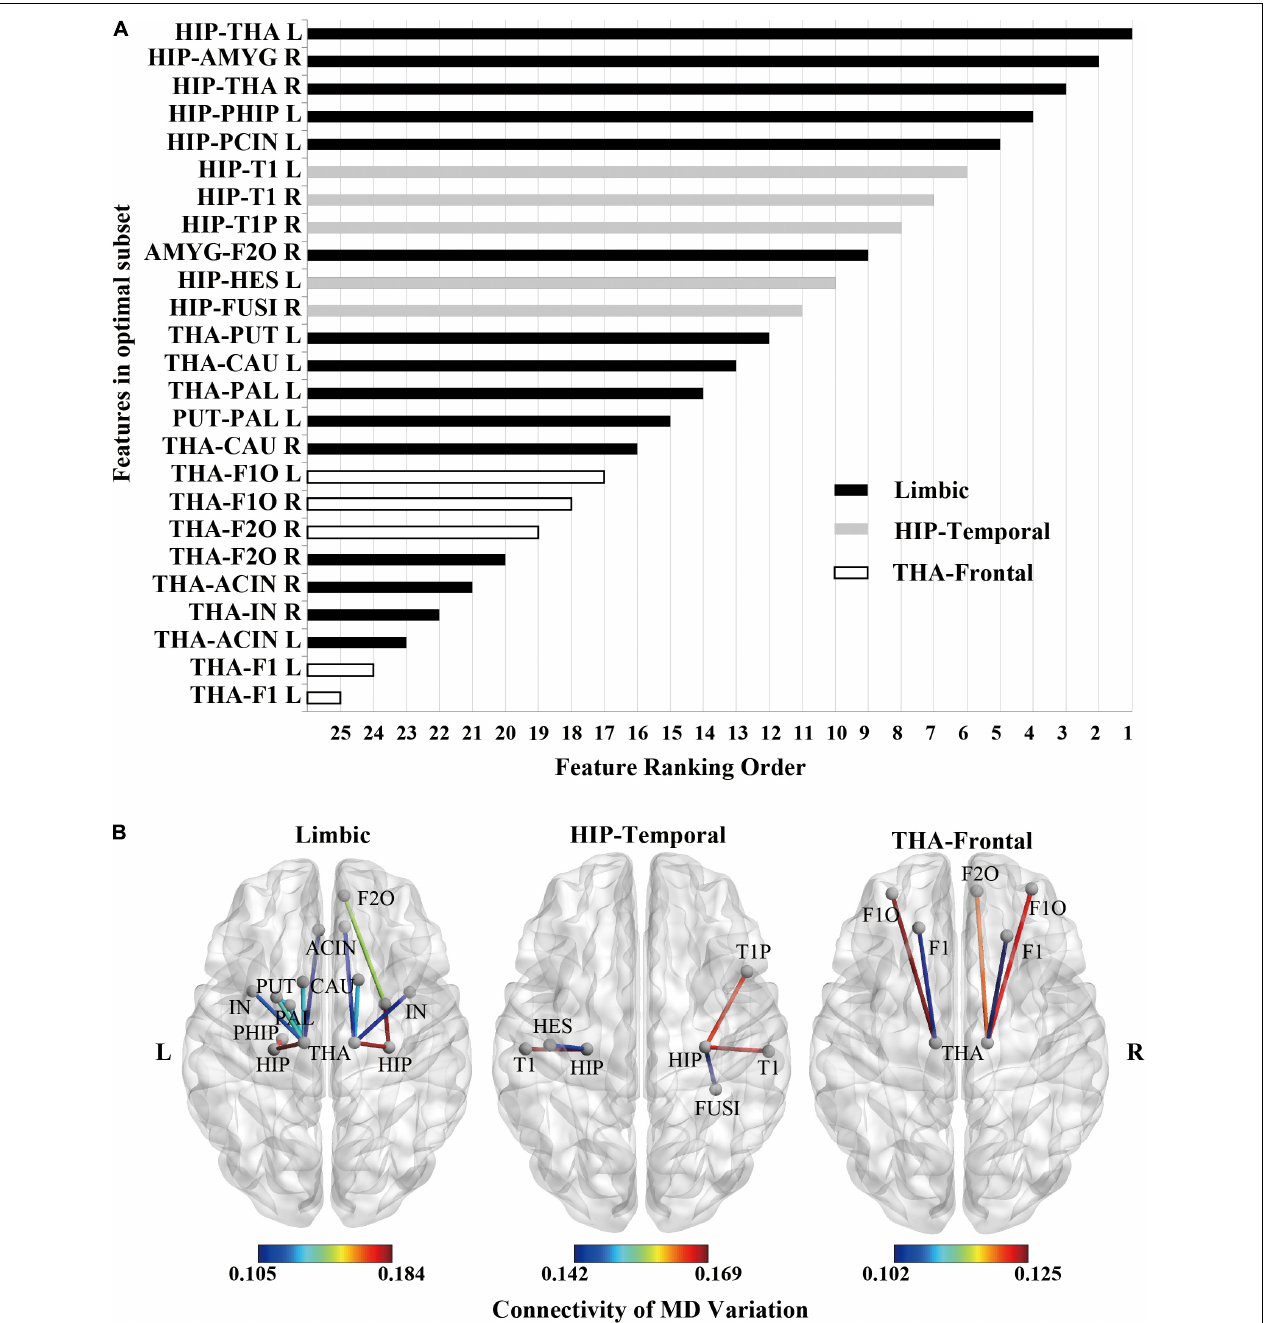
FIGURE 6 | Feature ranking of MD feature (the significant HIP-related WM network) as the result of RFE in SVM rbf model. (A) Feature ranking order of the most contributing connectivity (25 features). The bar represents connectivity in different groups. “black”: limbic connectivity (15 features). “gray”: Hip-temporal connectivity (5 features). “white”: THA-frontal connectivity (5 features). (B) Schematic illustration of degenerated white matter in MCI. Nodes represented ROIs from AAL templates. Edges represented connectivity; the value represents MD variation, MCI vs.